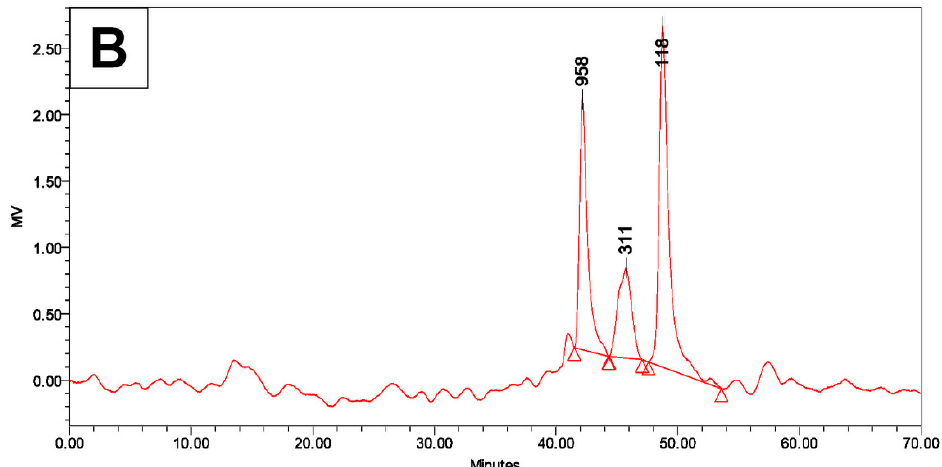
Figure 1. Size distribution of soluble particles of mealworm samples by gel permeation chromatography (GPC) analysis. ( A ) Defatted mealworm powder; ( B ) mealworm protein isolate.